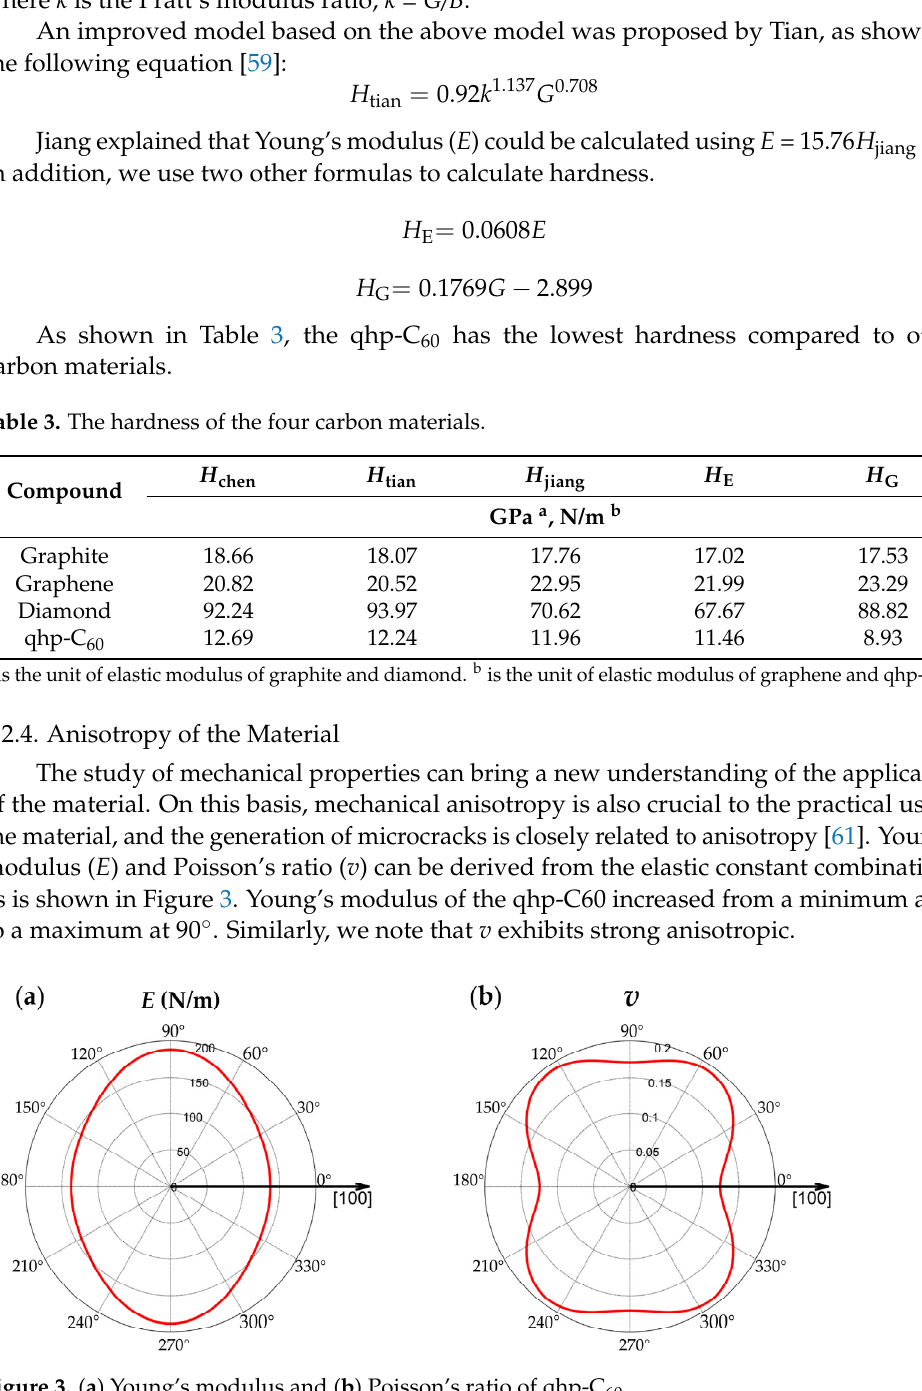
Figure 3. ( a ) Young’s modulus and ( b ) Poisson’s ratio of qhp-C 60